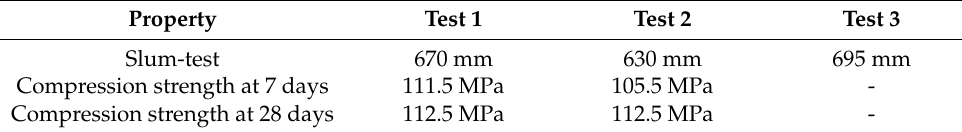
Table 9. Results of high-strength self-compacting concrete for lab